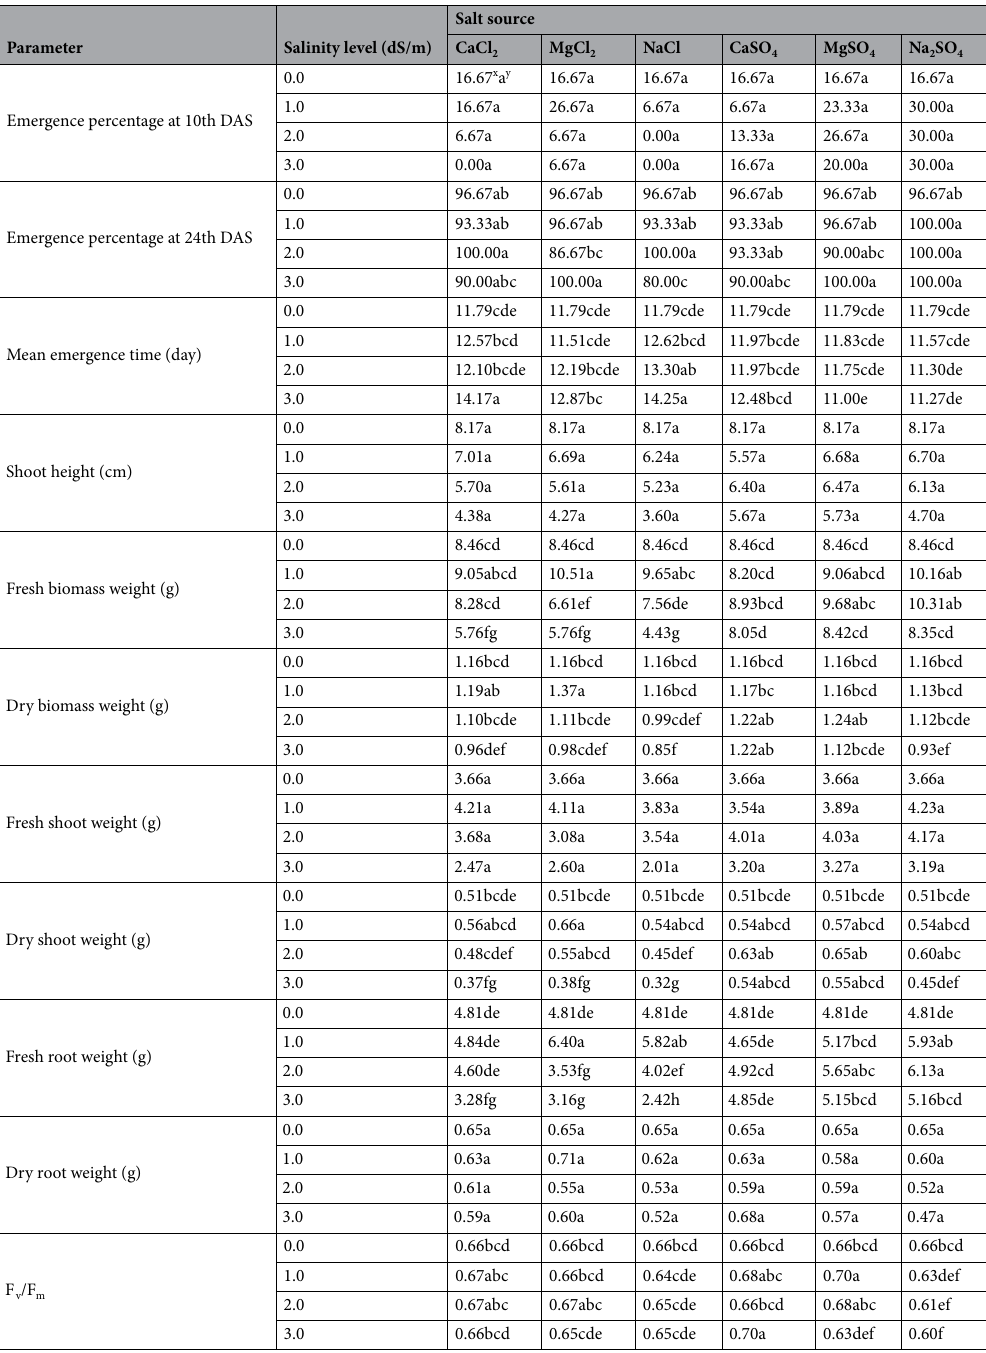
Table 4. The interaction effects of S × L on III-22 faba bean genotype. x Each value is the mean of three replications. y Within salt source and salinity level of each parameter, means followed by the same letter are not significantly different at the 5% level according to Duncan’s multiple range